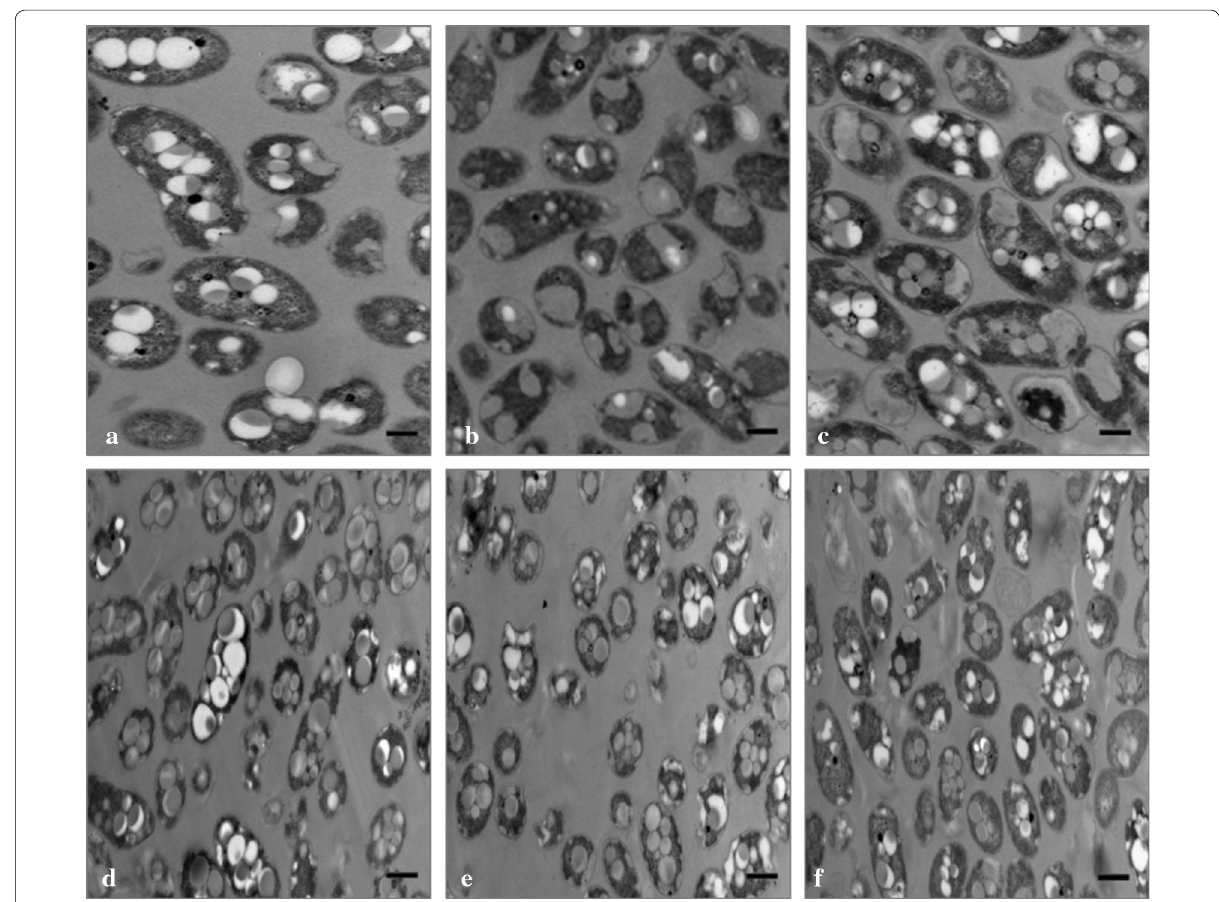
Fig. 4 Transmission electron microscopy of ultra‑thin sections of A. brasilense. Strains were grown on minimal medium containing malic acid and ammonium chloride at C:N ratios of 30:1 ( a – c ) and 90:1 ( e – g ). Strains were incubated at 32 °C and 110 rpm for 24 h. PHB granules of wild type ( A. brasilense Sp7) ( a and e ), mutant ( A. brasilense Δ phaP1 ) ( b and f ) and complemented ( A. brasilense PhaP1 +++ ) ( c and g ) strains are shown as intracellular granules. Label Scale bar 1 =